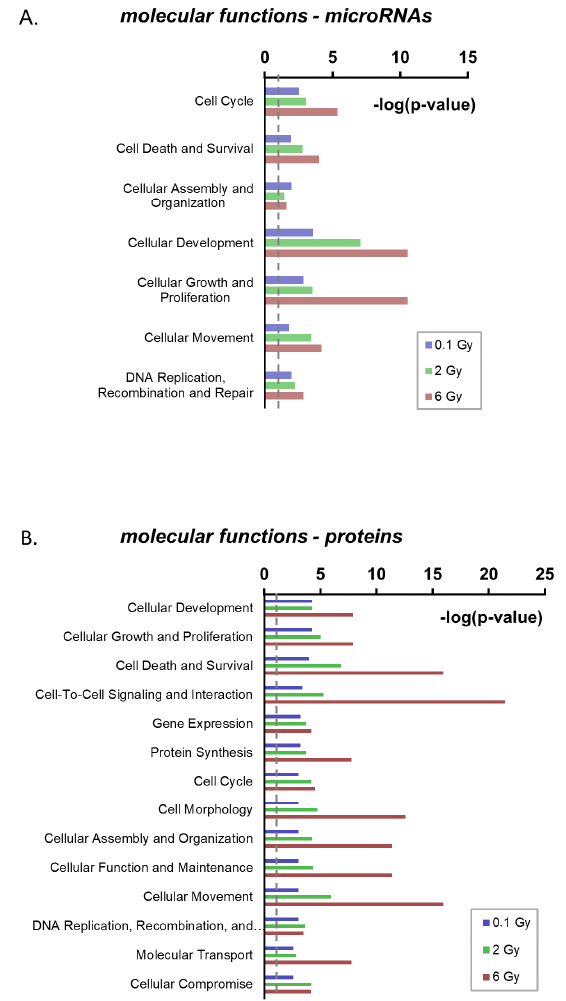
Figure 4. Ingenuity Pathway Analysis of radiation deregulated microRNAs and proteins in extracellular vesicles. ( A ) Enrichment analysis of molecular functions for radiation-deregulated miRNAs. ( B ) Enrichment analysis of molecular functions for radiation-deregulated proteins. Only pathways significantly enriched at all three doses are shown. (dashed line displays p = 0.05).